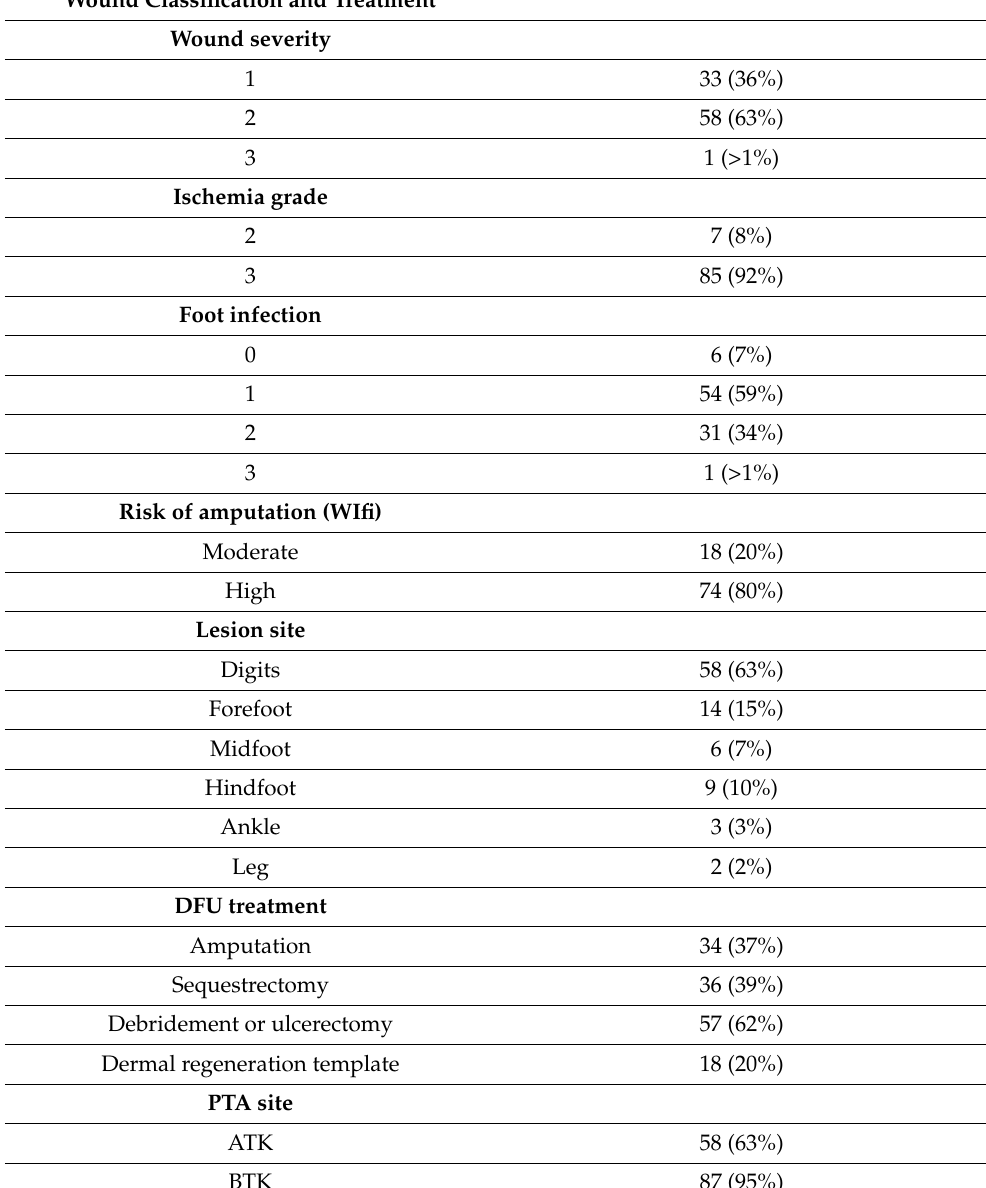
Table 2. Characteristics of the lesions and interventions. Variables are expressed as the number of patients and percentage of the population. Wound and ischemia grades are reported according to the Society for Vascular Surgery Wound, Ischemia, and foot Infection (WIfI) classification [6]. As some patients required more than one type of surgery or revascularization, the sum of patients of the different types of treatments exceeds 100%. Abbreviations: above the knee (ATK); below the knee